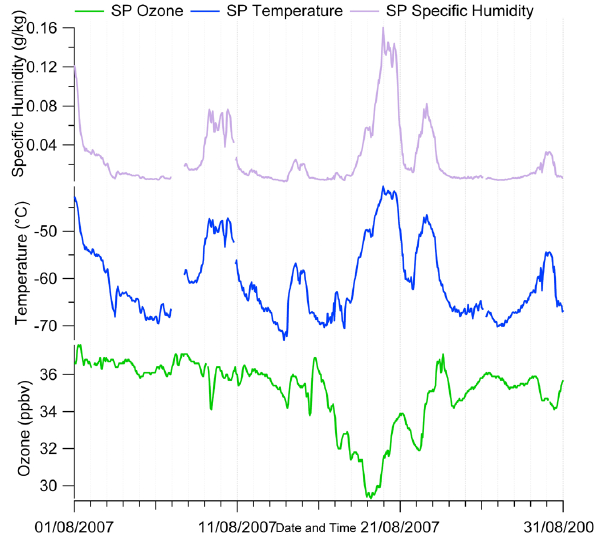
Fig. 11. South Pole surface ozone, temperature and specific humid- ity, from 1–31 August